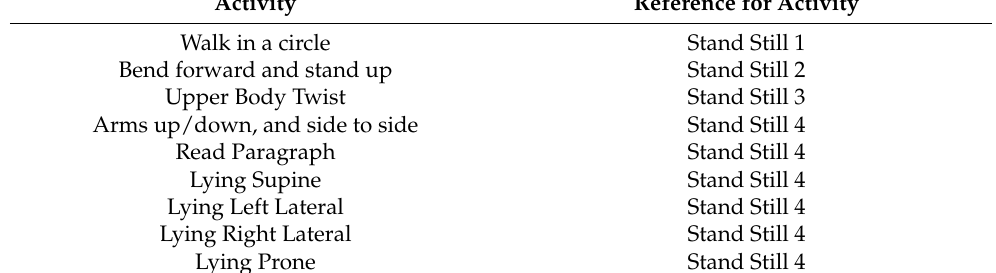
Table 3. List of activities that introduce noise in the heart sound signal and the corresponding reference activities that represent the signal.